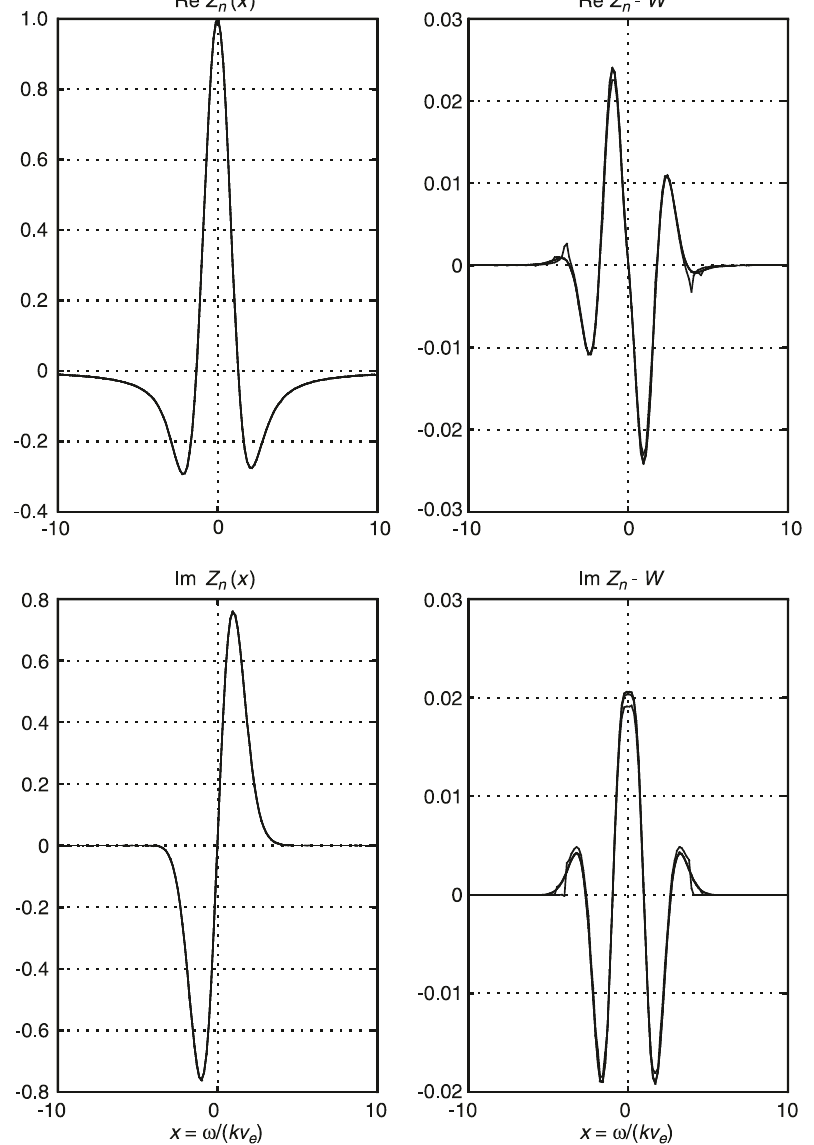
Fig. 8. On the left, the real and imaginary parts of Z n for real argument and for (cid:15) T (cid:136) 5 (cid:1) 10 (cid:255) 2 and (cid:15) E (cid:136) (cid:255) 3 (cid:15) T (cid:99) = 4 (cid:99) . On the right the di(cid:128)erence T E between Z n and W for the four di(cid:128)erent values of